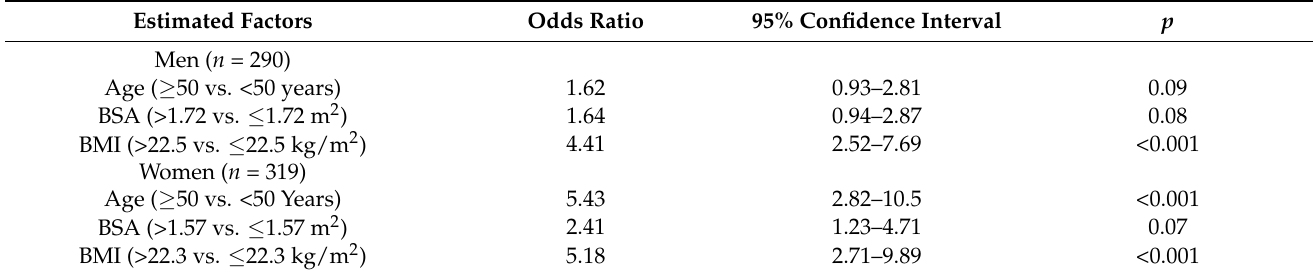
Table 3. Multivariable analysis of risk factors for visceral obesity in Chinese adults with normal BMI ( n = 609).